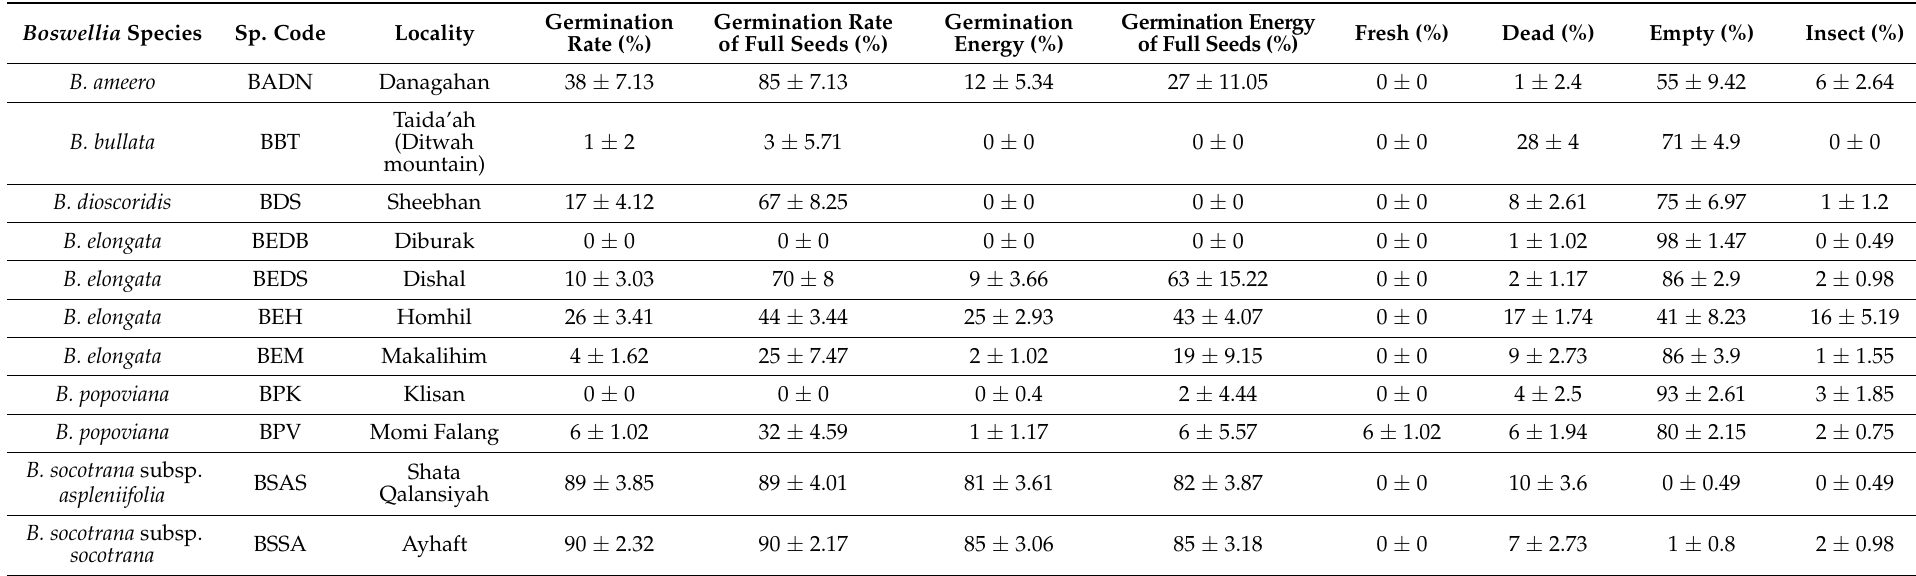
Table A1. Mean values from germination tests in 2020 ( ± standard